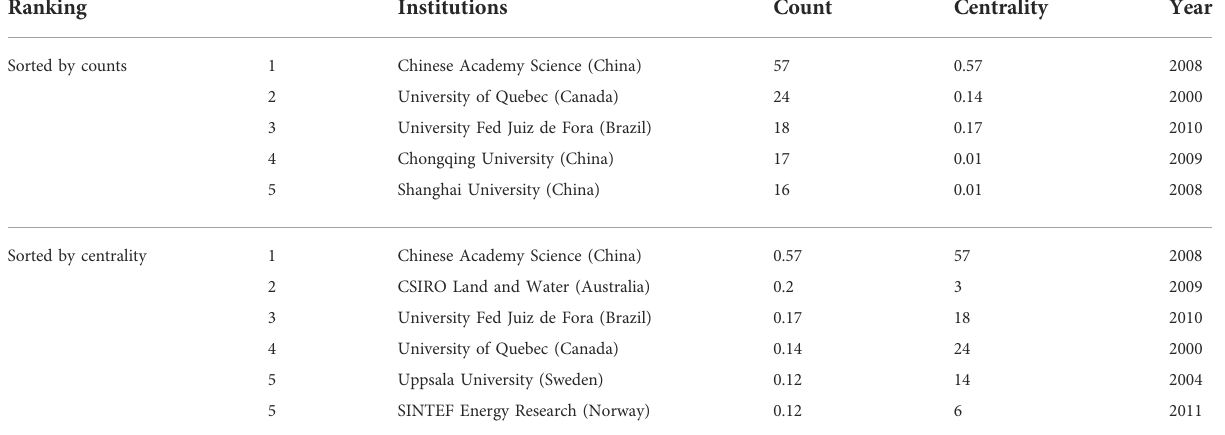
TABLE 5 Top fi ve institutions in GHG-HR research fi eld. Ranking Institutions Count Centrality